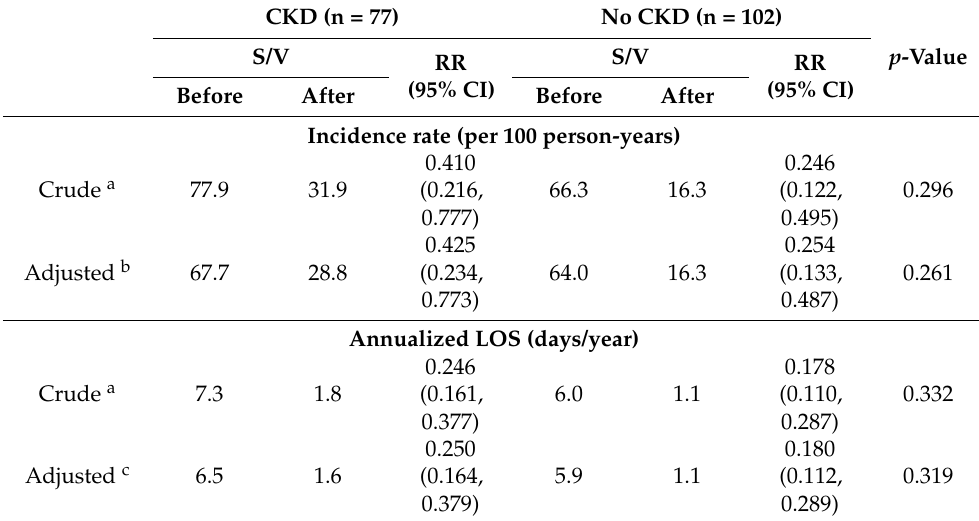
Table 2. Effect of treatment initiation with Sacubitril/Valsartan on the incidence rate and annualized LOS of hospitalizations due to HF decompensation stratified by CKD at baseline. CKD (n = 77) No CKD (n =